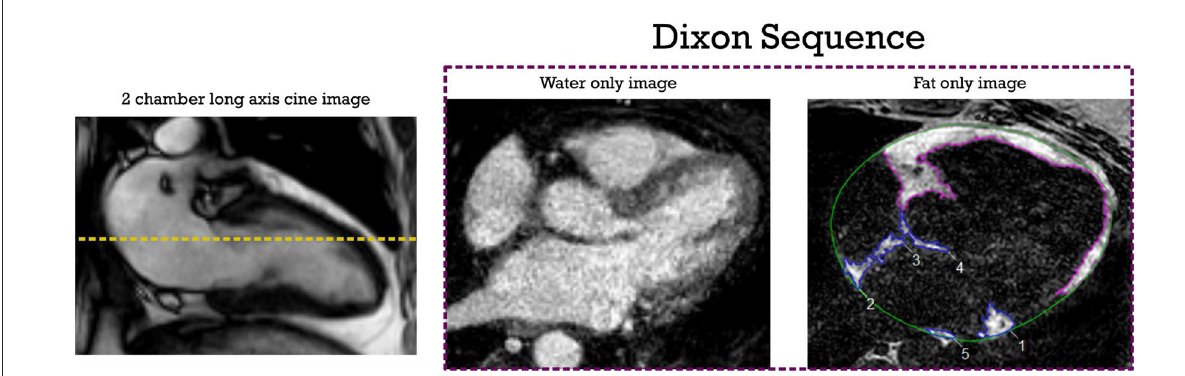
FIGURE1 EAT segmentation from axial Dixon MRI sequence. The dotted yellow line shows the measurement level in the LA. High intensity signal areas around LA (inferior pulmonary vein level in this example) are manually contoured in blue using point by point contour tools. Ventricular EAT is contoured in purple; Total epicardial fat is calculated by adding atrial and ventricular EAT across all slices. The pericardial outline is shown in green. EAT, epicardial adipose tissue; LA, left